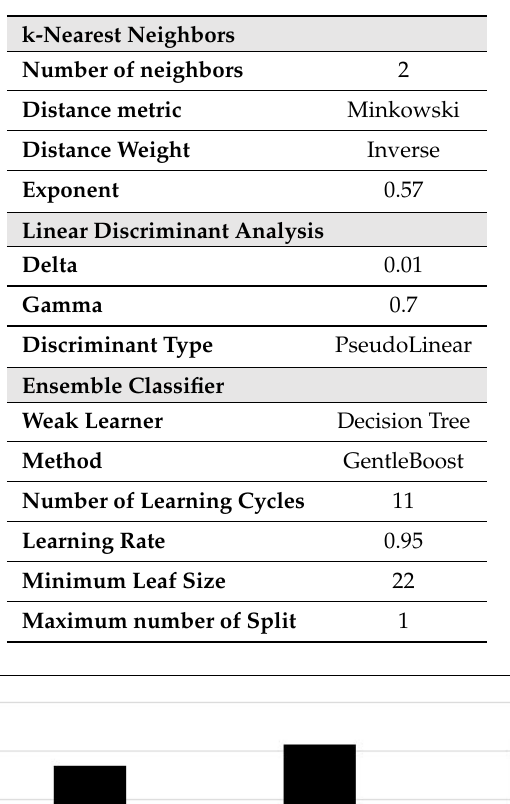
Table 2. Selected parameters for the classifiers.